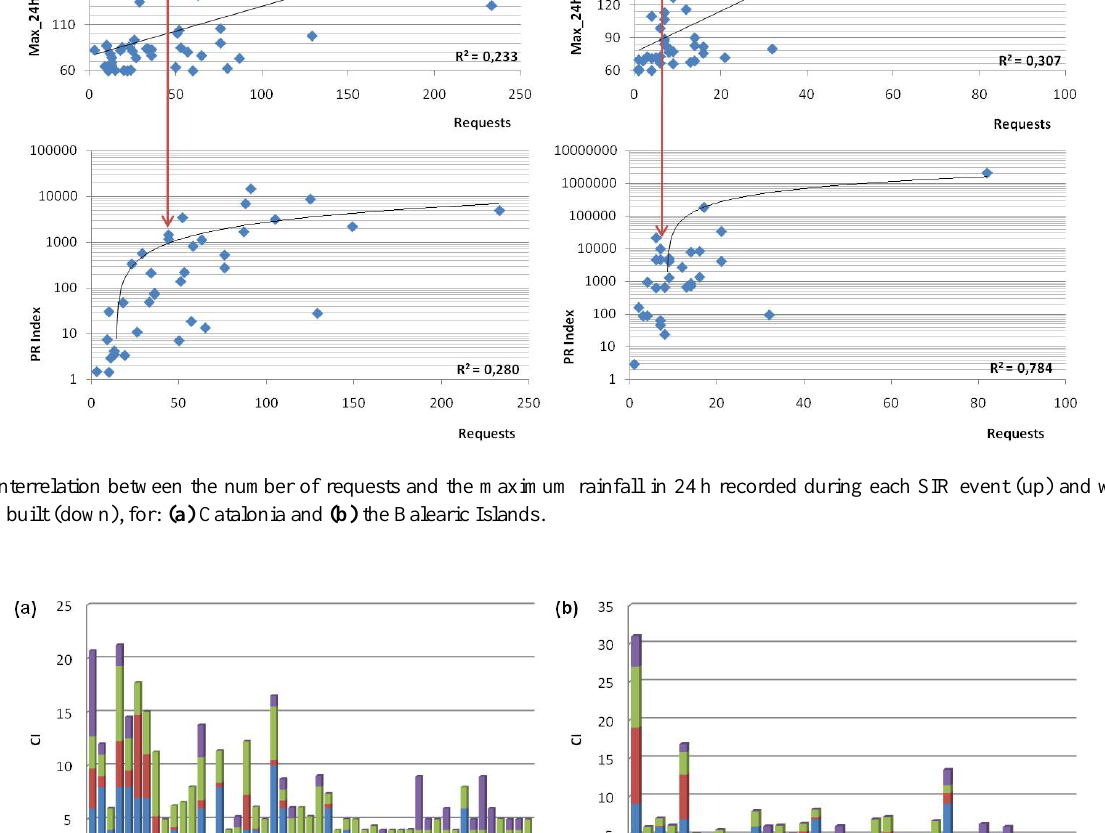
3. Length of the event ( L TR ) (Pielke and Downton,